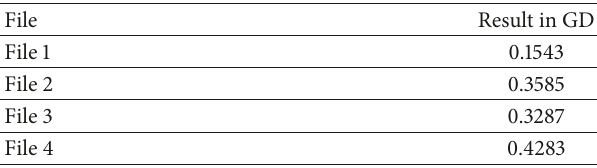
Table 7: The result of applying the metric GD.